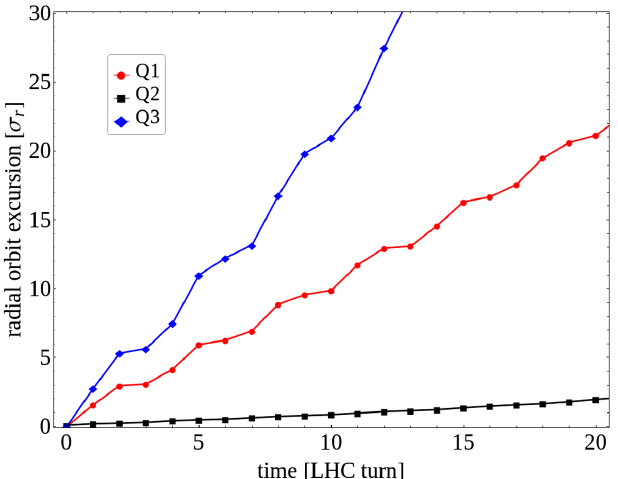
three types of triplet magnets Q1, Q2, and Q3. For each type, only the magnet with the largest kick is